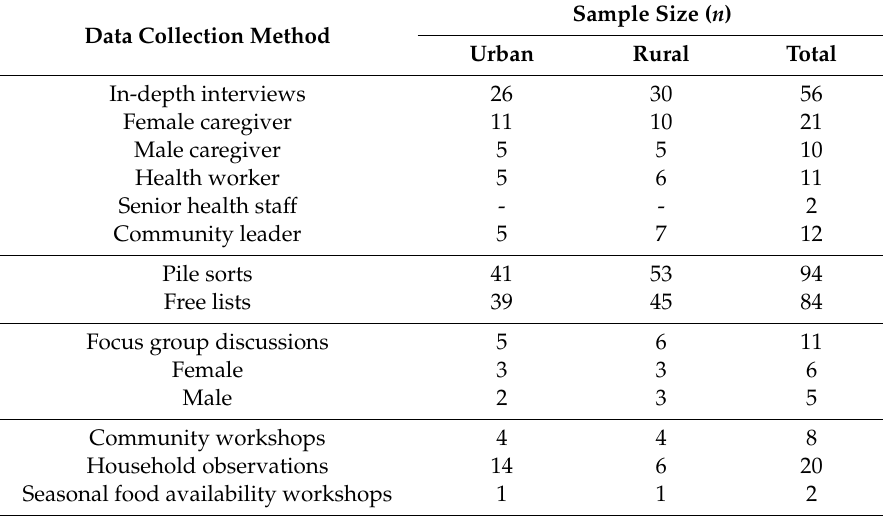
Table 3. Final sample sizes and participant types by data collection